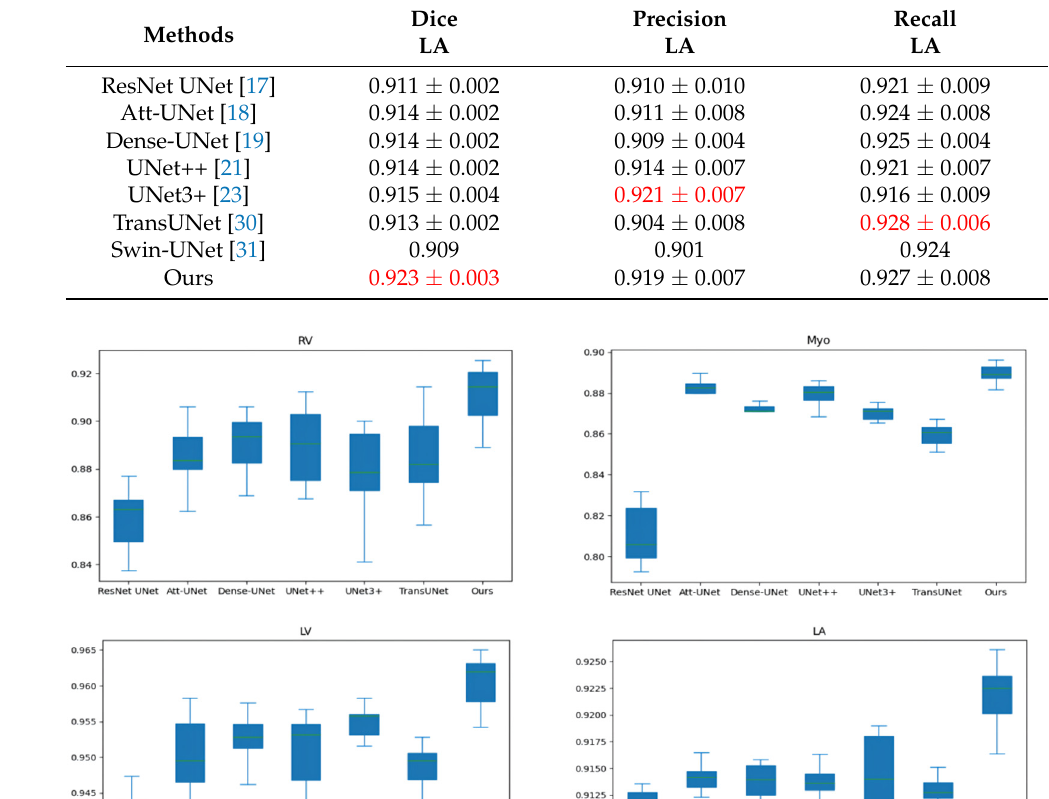
Table 3. Comparison with state-of-the-art methods on the 2018 ASC. All methods were run 10 times to take the average and standard deviation (average ± standard deviation). The best performance is shown in red. (the data of all methods are that we train under the same conditions, and the standard deviation of Swin-UNet is not available).